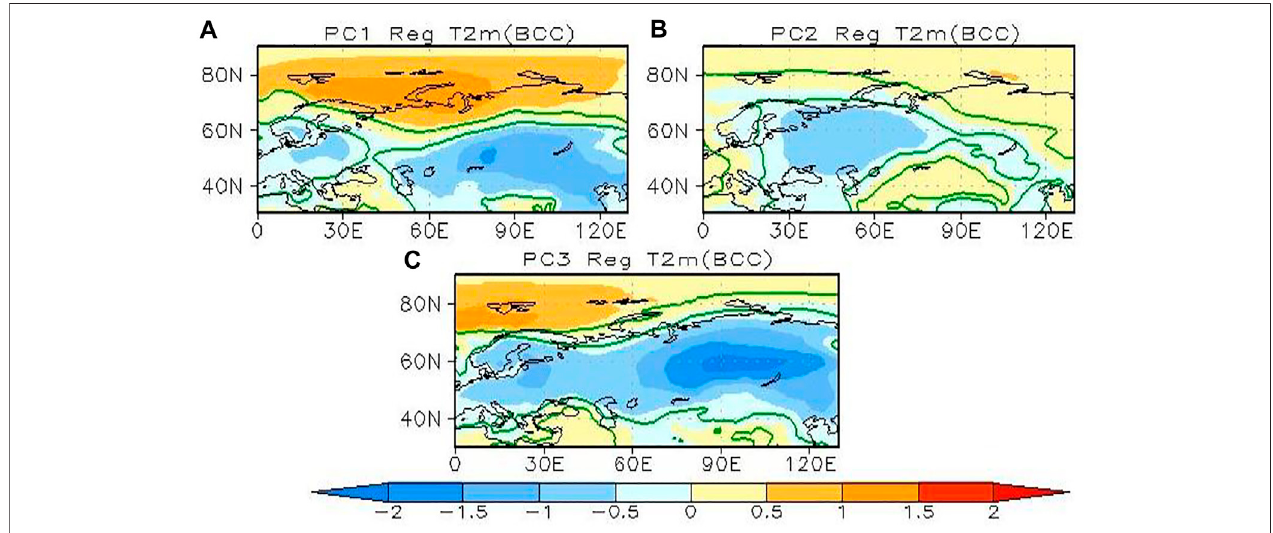
FIGURE 12 | Regressed anomalies of DJF T2m (shading, units: ° C) onto the simulated (A) PC1, (B) PC2, and (C) PC3 index from the BCC-CSM2-MR model. The green line indicates the value signi fi cantly exceeding the 95% con fi dence level.